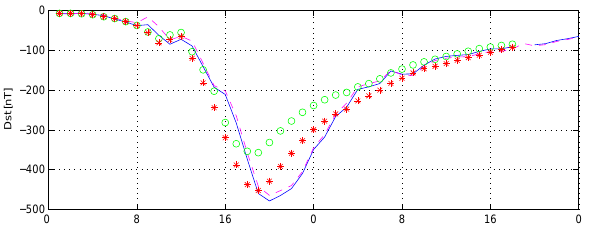
Fig. 12. Measured and predicted D st development for 20–21 November 2003. The blue solid line is the 1-h D st index and the purple dashed line is D ∗ st . The green open circles show the pre- dicted D ∗ st using the O’Brien and McPherron (2000a) model and the red stars the predicted D ∗ st using the Wang et al. (2003a)